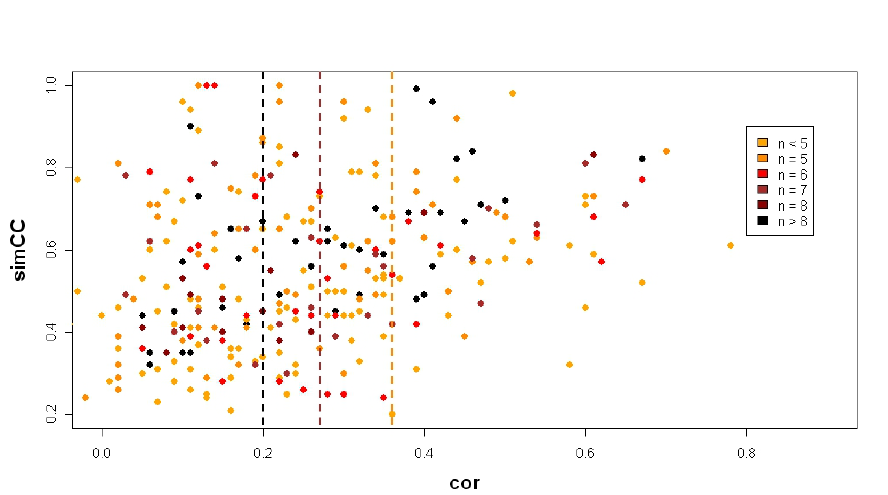
Figure 3: Coherency of co-expression and location within modules. The similarity of cellular localization (simCC) is plotted against the Spearman correlation. The size of the detected modules is colour-coded. The number n in the figure legend denotes the number of proteins included in the modules. Dashed lines indicate thresholds for different modules sizes where 99% of the correlation values in random samples are smaller for n = 5, n = 8 and n >